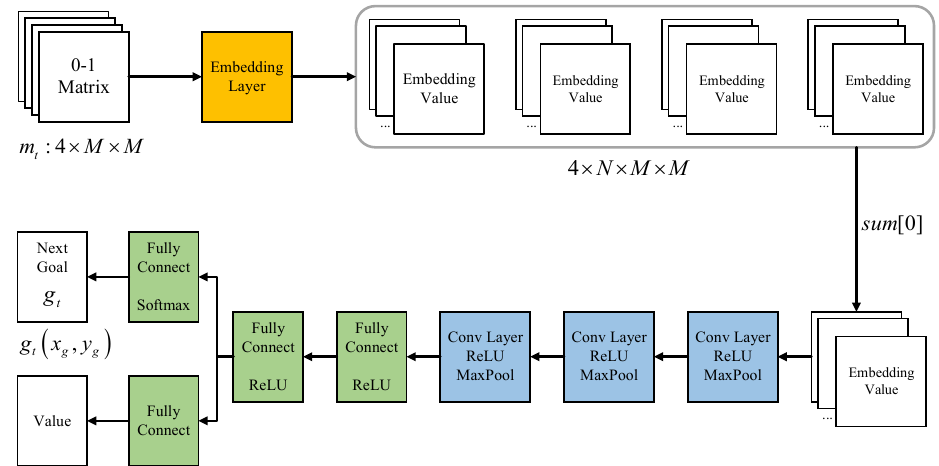
Figure 3. The structure of the actor-critic network in GEM. N represents the size of each embed- ding